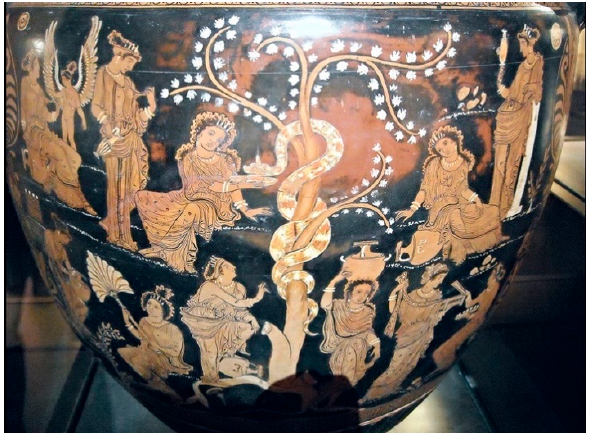
Figure 2. The Garden of the Hesperides (Ruvo, Archaeological Museum inv. no. 1097); red-figure volute-krater; attr. to the Lycourgos Painter, Ruvo di Puglia; ca. 360 BCE . [Image creative commons public domain].